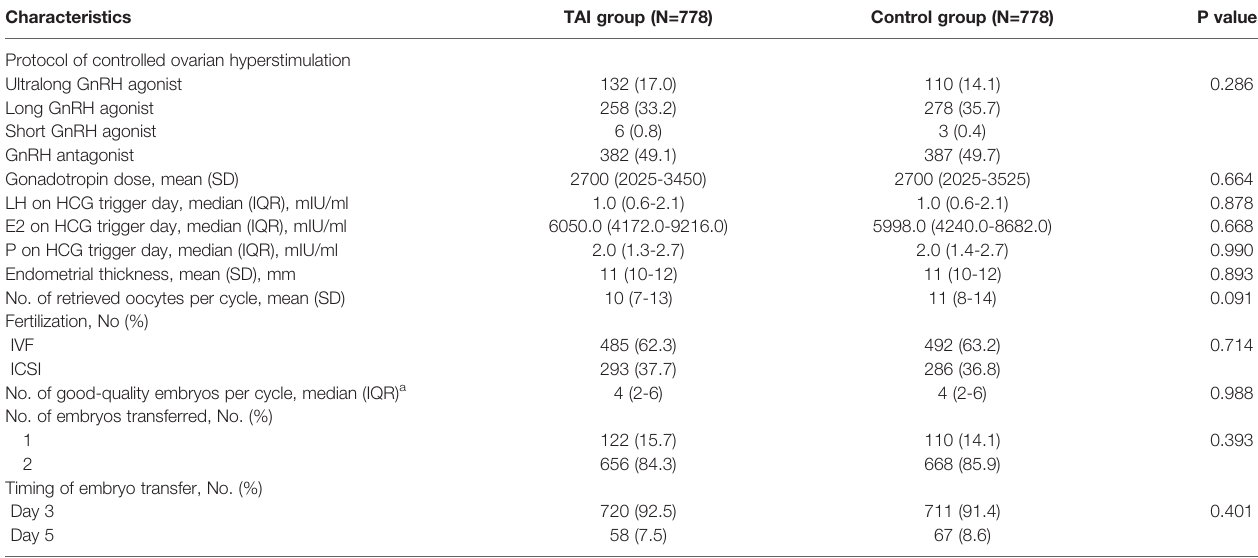
TABLE 2 | Protocols of controlled ovarian stimulation and data of in vitro fertilization and embryo transfer. Characteristics Protocol of controlled ovarian hyperstimulation Ultralong GnRH